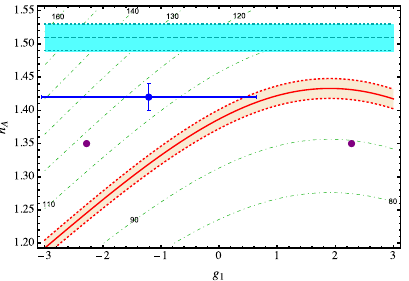
Figure 3. h A as a function of g 1 . The central line corresponds to Γ ∆ = 100 MeV, while the band is obtained by varying Γ ∆ ∼ 98 − 102 MeV. The dot-dashed lines correspond to delta widths indicated by their values. The blue dot with error bars represents the real part of the coupling fitted to π N scattering, the purple dots stand for the leading order π N ∆ coupling in the large- N c limit and the horizontal dashed line with cyan band corresponds to the value (with error represented by the band) from Ref.